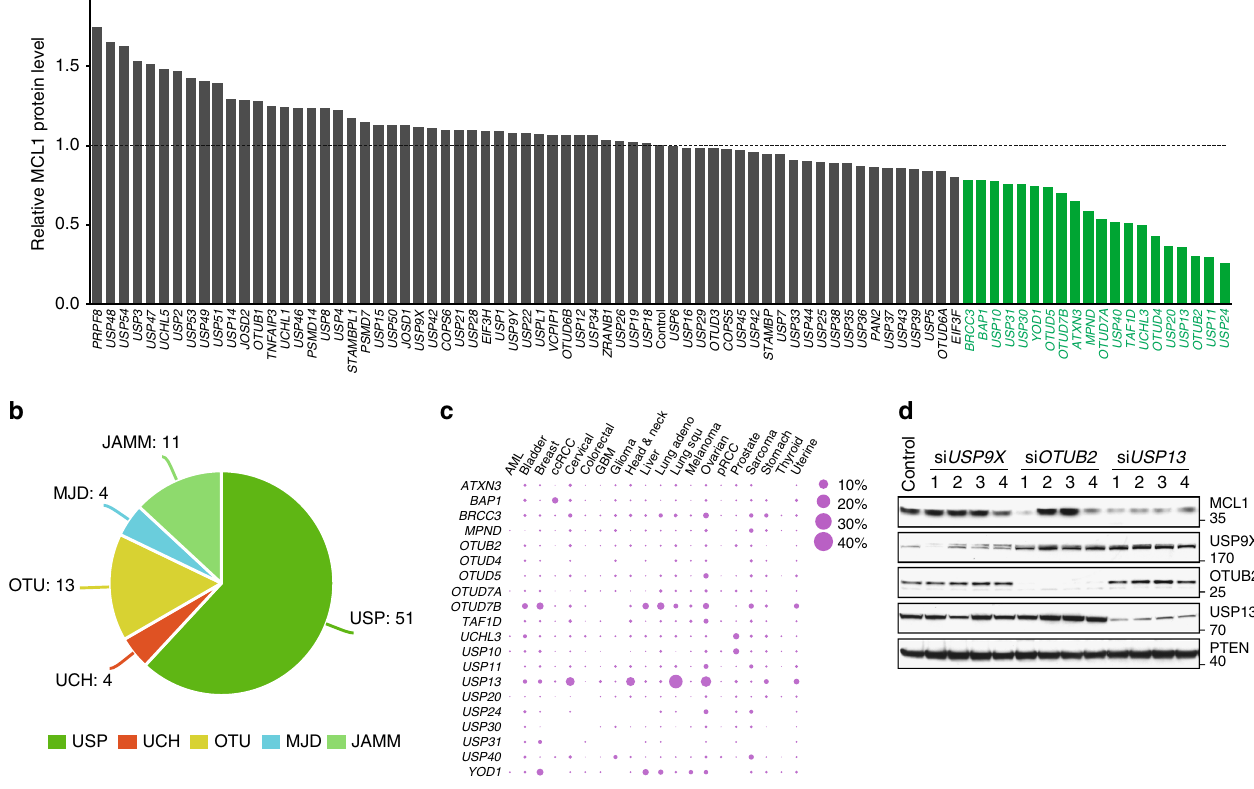
Fig. 1 Identi fi cation of USP13 as a candidate MCL1 deubiquitinase. a The quanti fi cation of MCL1 protein levels upon knockdown of each DUB in HEK293T cells. 84 siRNA pools were individually transfected into HEK293T cells, endogenous MCL1 was detected by western blotting and protein bands were quanti fi ed using the Image J software. b Classi fi cation of the 84 human DUBs included in siRNA screen. c Dot plot of copy number alterations for 20 candidate MCL DUB genes in TCGA cancers. d Validation of the candidate MCL1 DUBs in HEK293T cells. Four different siRNAs targeting USP9X , OTUB2 , or USP13 were transfected into HEK293T cells, and endogenous expression levels of indicated proteins were measured by western blot